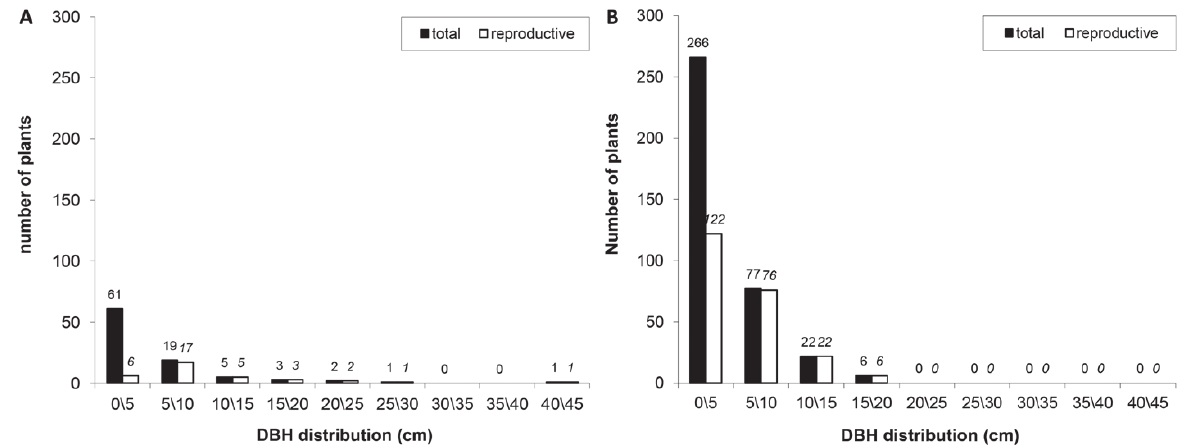
Figure 6 - Diametric distribution of Drimys brasilienis in the Forest Genetic Park of Caçador (A) and Caçador National Forest (B) , according to Mariot et al.